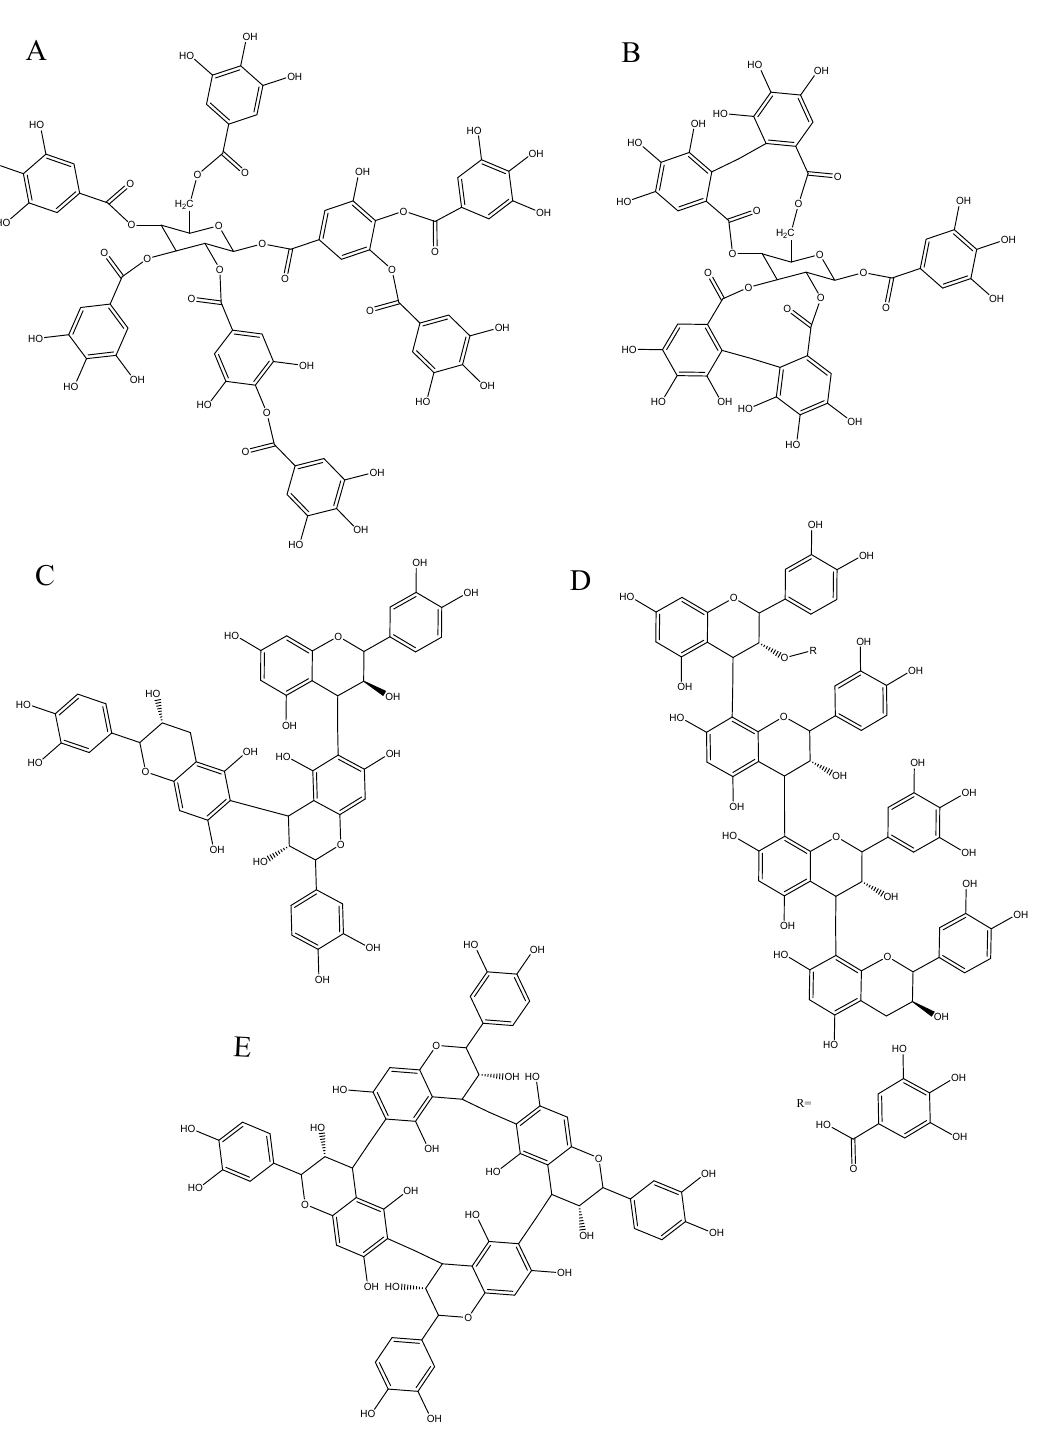
Figure 1 . Chemical structure of hydrolyzable tannins, gallotannins ( A ); and ellagitannins ( B ); and condensed tannins including trimer of catechin and epicatechin linked in C4-C6 ( C ); tetramer composed of epicatechin gallate, epicatechin, epigallocatechin and catechin ( D ); and crown procyanidin consisting in a tetramer of epicatechin linked in C4-C6 and C4-C8 ( E ). The nature of the constitutive units varies according to the source, such as ( + )-catechin and ( − )-epicatechin that are commonly found in fruits, while ( + )-gallocatechin and ( − )-epigallocatechin are more common in leaves [36,37]. Constitutive units include extension units that are monomers connected to two other units, and terminal units, which are connected to only one unit in the